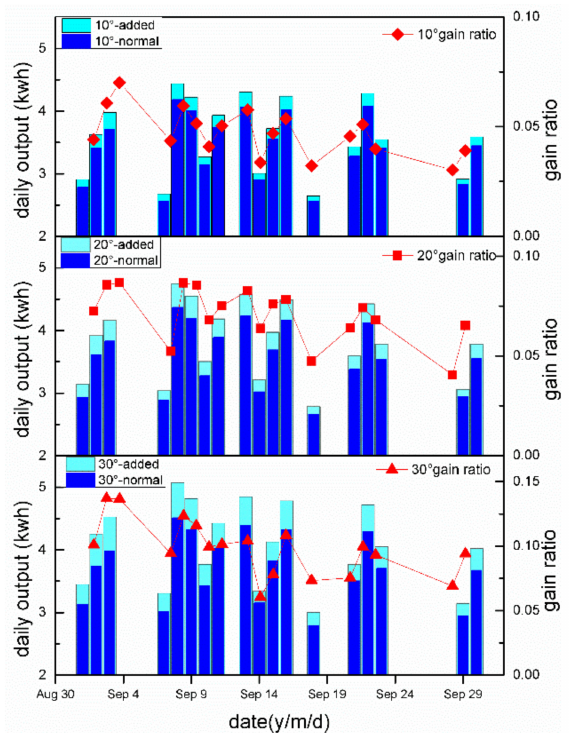
Figure 14. Comparison of the power generation and light gain of the prototype bifacial companion system in September before and after light